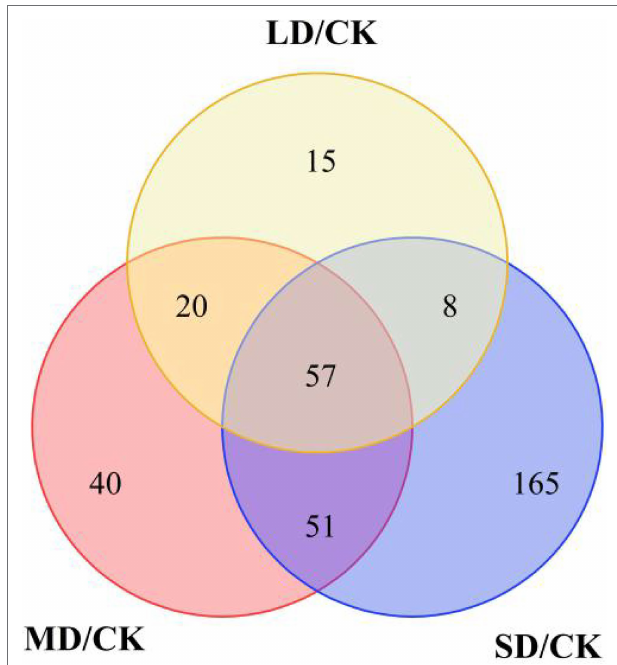
FIGURE 3 | Differentially accumulated metabolites shown in Venn diagram